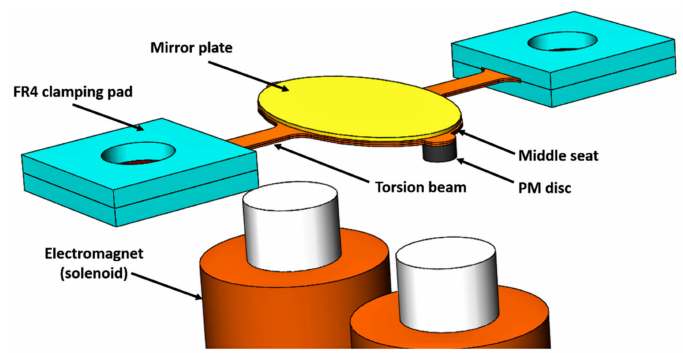
Figure 1. The external electromagnet flexible printed circuit board (FPCB)